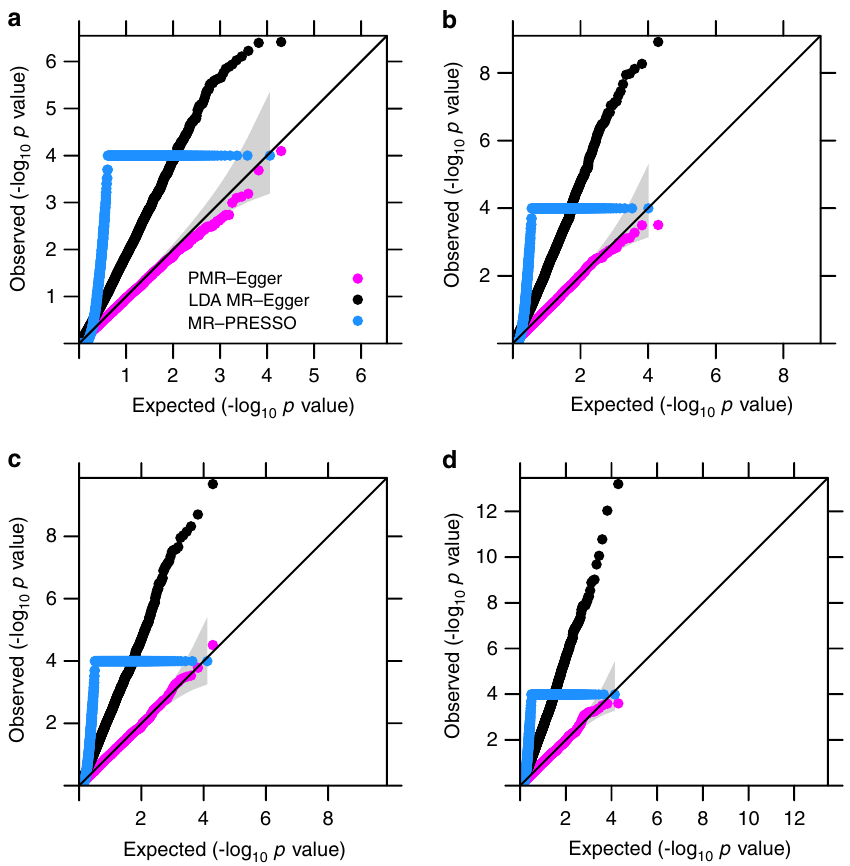
Fig. 3 Type I error control for different methods on testing pleiotropy. Quantile – quantile plot of − log10 p -values from different methods for testing the horizontal pleiotropic effect either in the absence or in the presence of causal effect under null simulations. Compared methods include PMR-Egger (magenta), LDA MR-Egger (black), and MR-PRESSO (dodger blue). Null simulations are performed under different causal effect sizes characterized by PVE zy : a PVE zy = 0; b PVE zy = 0.2%; c PVE zy = 0.4%; and d PVE zy = 0.6%. Only p -values from PMR-Egger adhere to the expected diagonal line across a range of horizontal pleiotropic effect sizes. Due to heavy computational burden, we are only able to run 10,000 permutations for MR-PRESSO. Therefore, the minimal p -value from MR-PRESSO is 10 − 4